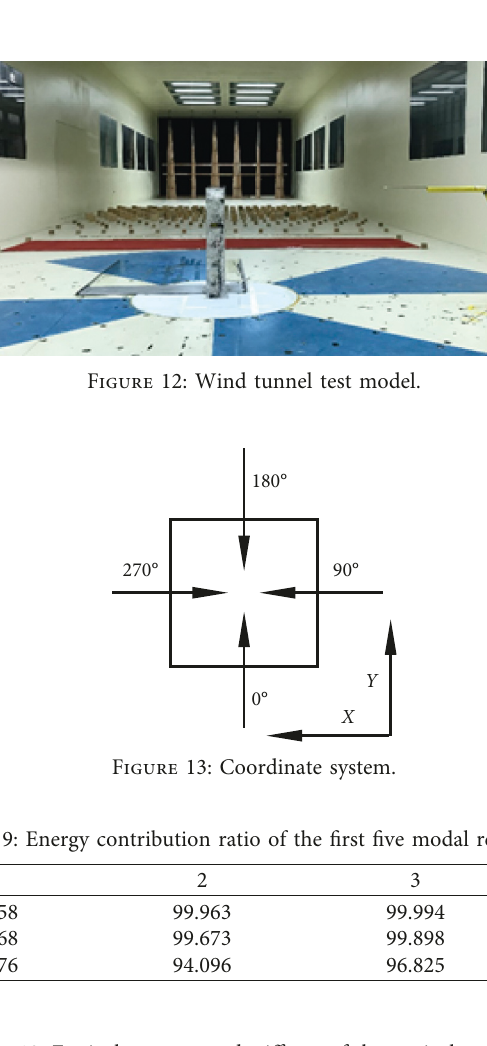
Table 10: Equivalent mass and stiffness of the equivalent model.